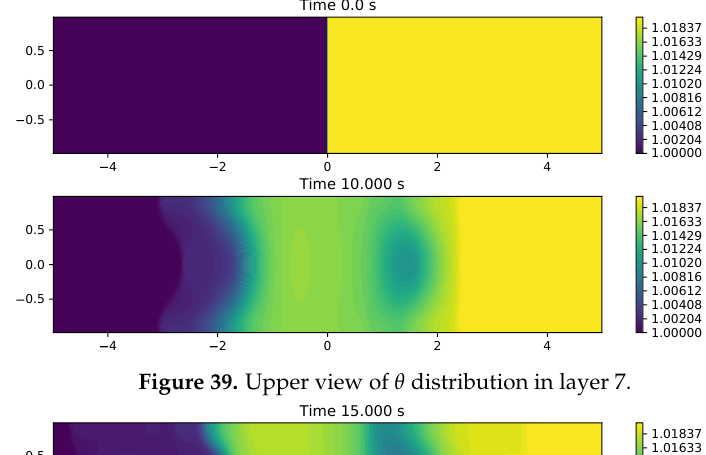
Figure 39. Upper view of θ distribution in layer 7.